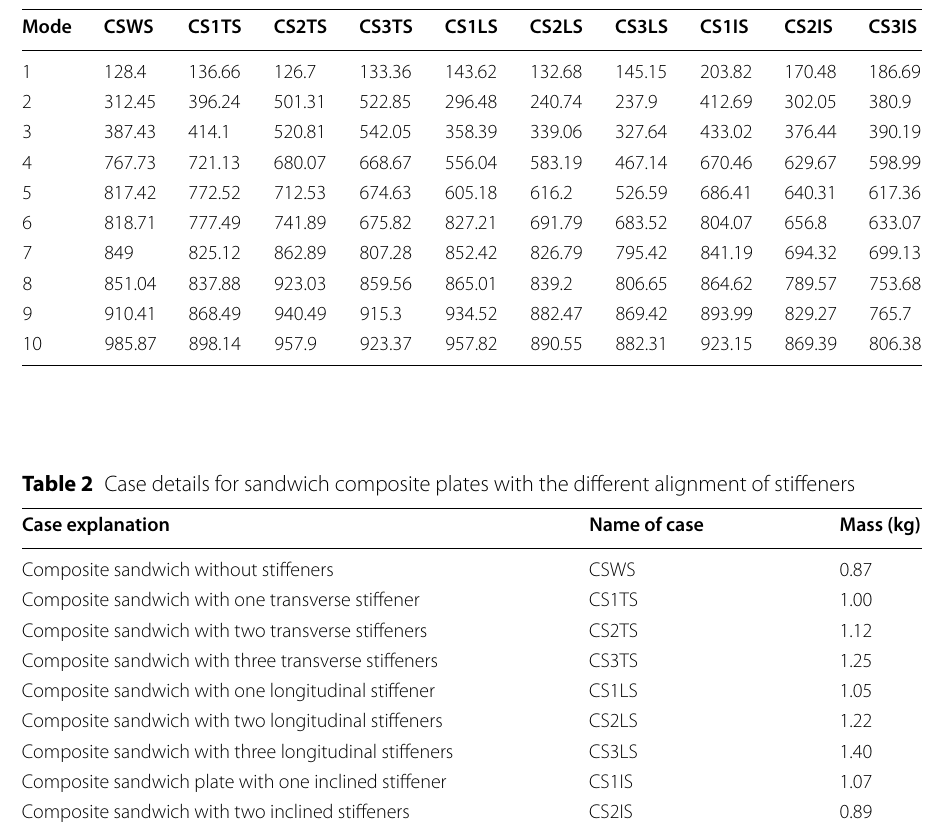
Table 1 The natural frequency of the plates with the different alignment of stiffeners Natural frequency (cycle/time) for the bridge deck panels Mode CSWS